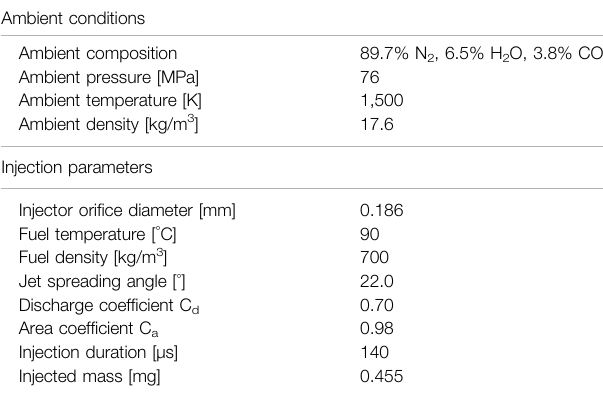
TABLE 1 | Simulation setup and boundary